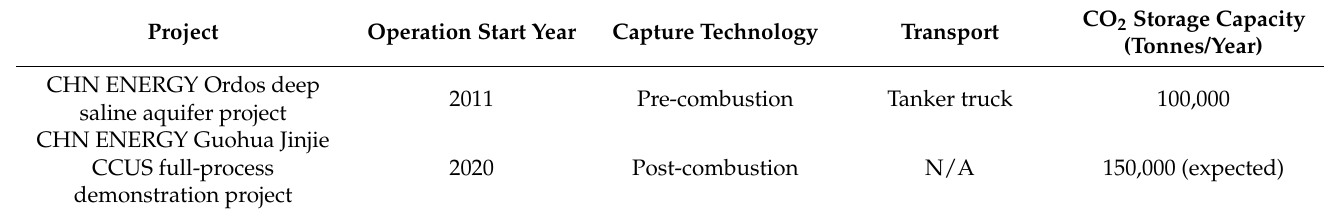
Table 9. CO 2 storage projects in deep saline aquifers in China